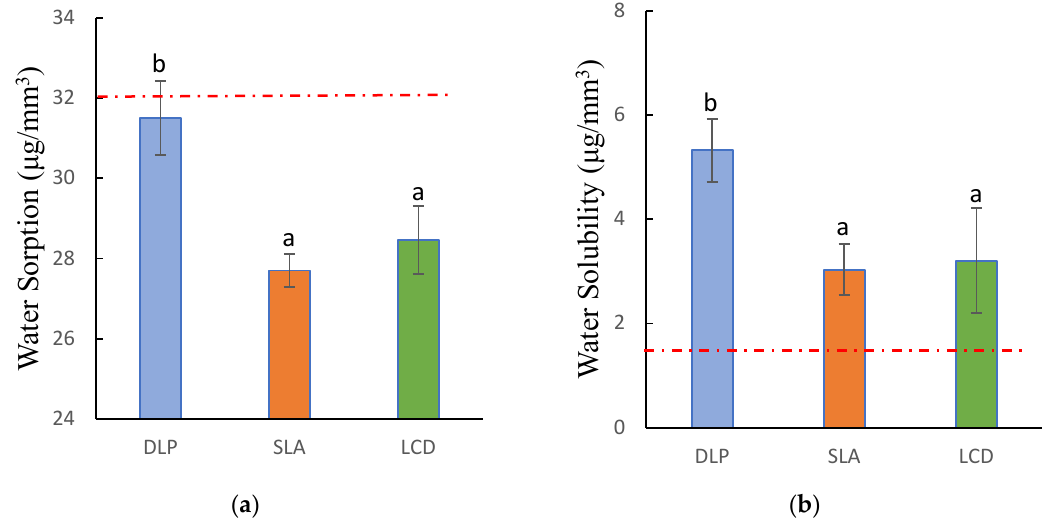
Figure 8. Water sorption and solubility of 3D-printed denture base resin: ( a ) water sorption; ( b ) water solubility. Similar letters indicate insignificant differences. Red dotted lines indicated the maximum requirements according to ISO standards.